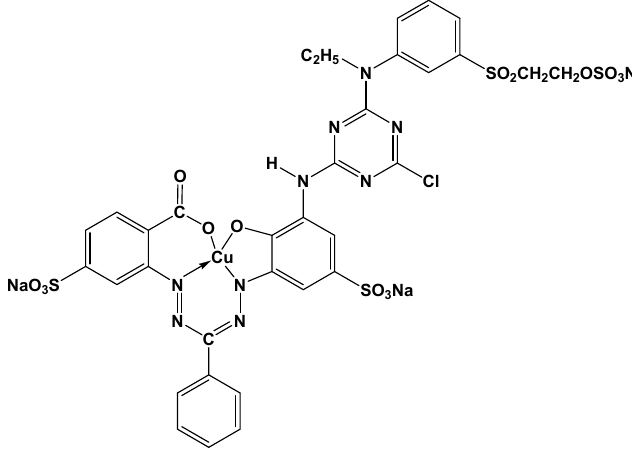
Figure 1. Chemical structure of the C.I. Reactive Blue 221 (RB221) dye.